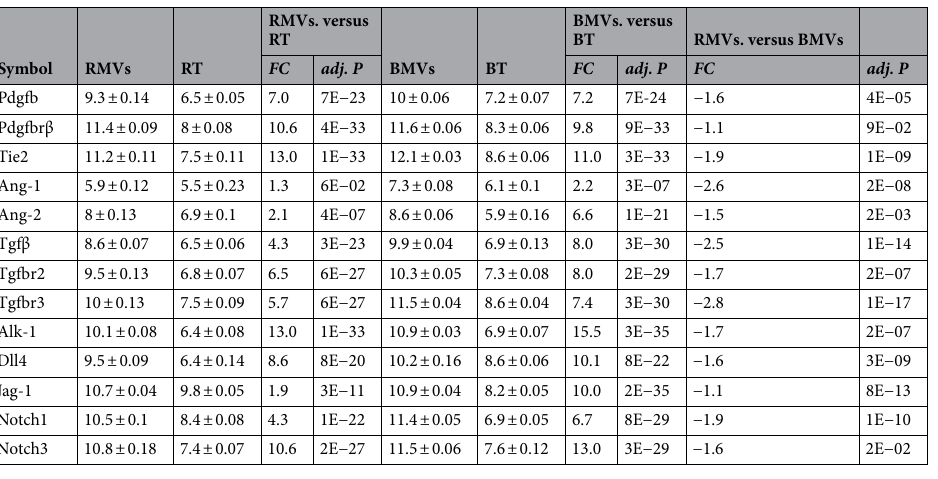
Table 5. List of signaling genes between endothelial cells and pericytes differentially expressed in rat retina and/or brain microvessels vs. retina and brain tissue samples. Results are mean ± SEM of log 2